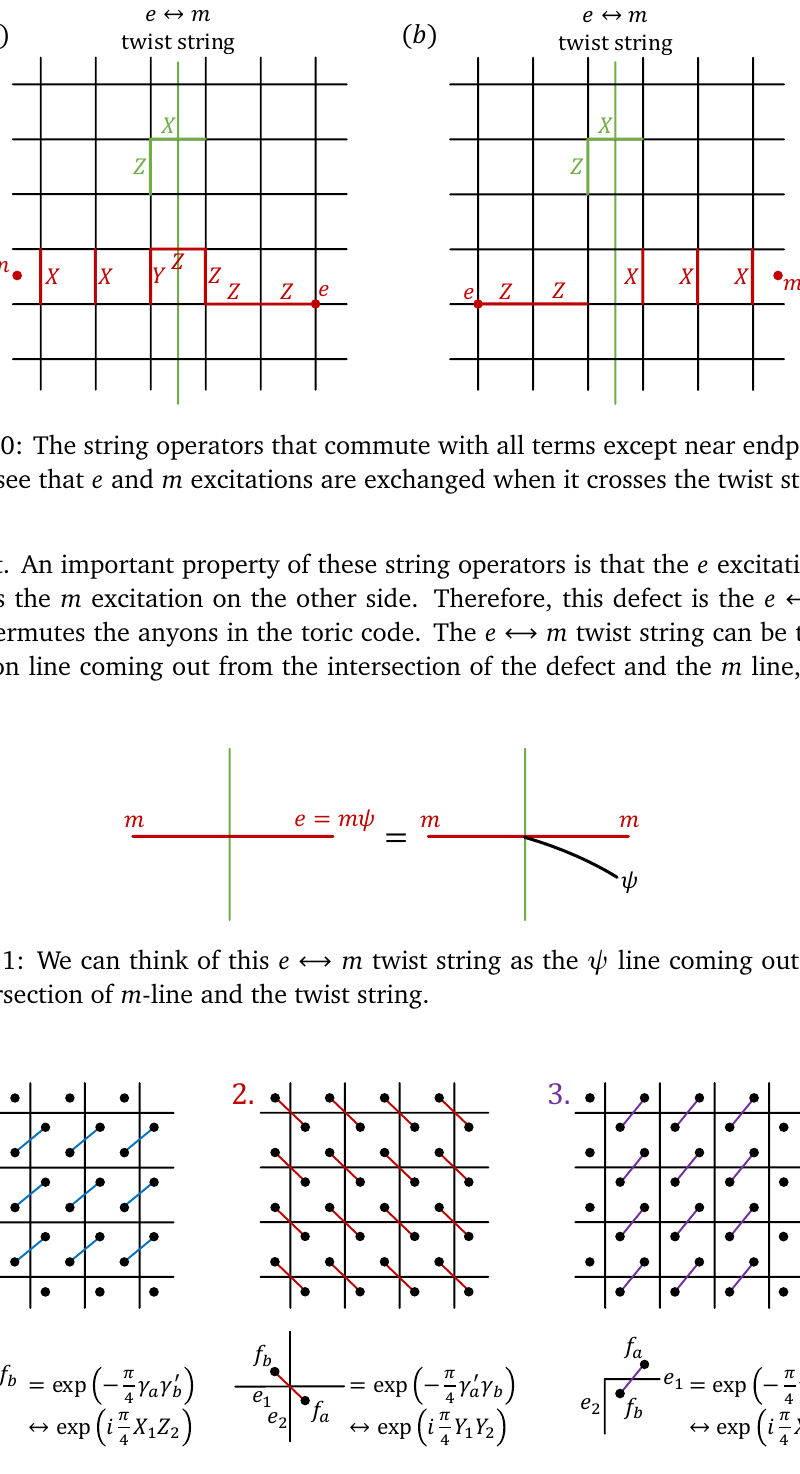
Figure 12: The operator pumping the Kitaev chain or the e ↔ m twist string. The circuit has three steps, and each step is a product of swap operations of Majorana